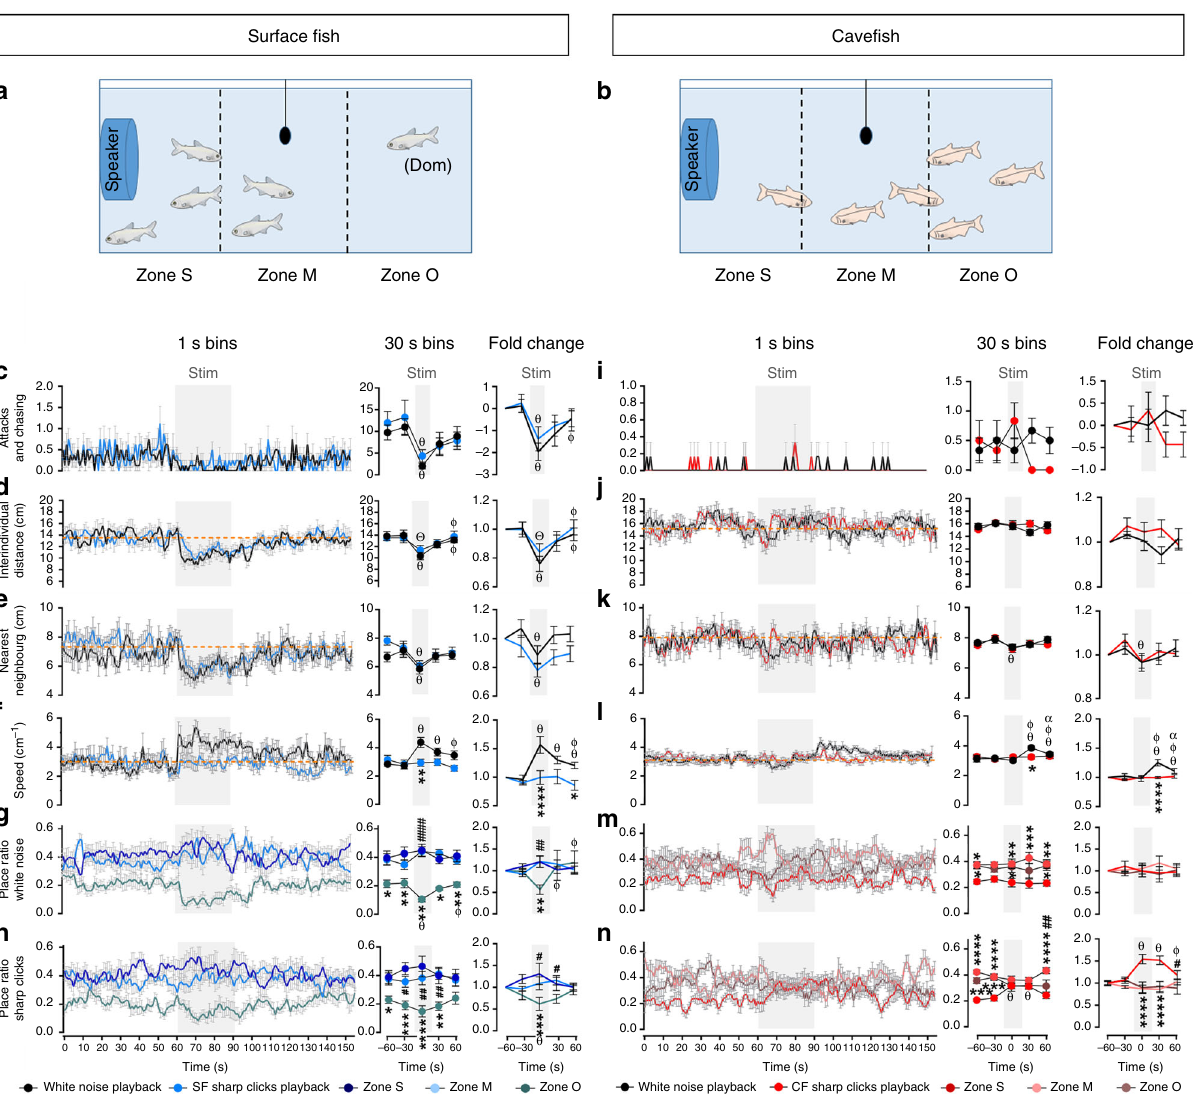
Fig. 5 Effect of Sharp Clicks or white noise play-back on fi sh behavior. Several behavioral parameters were measured before, during and after play-back (grey area, Stim) of Sharp Clicks (colored lines) or white noise (black lines) in surface fi sh (blue graphs, left columns) and cave fi sh (red graphs, right columns). Results are presented at one second bins and 30 s bins, as well as in fold change respective to the “ before sound play-back ” condition. a , b , Schemes of the experimental set-up, with representative distributions of the fi sh in the 3 zones of the tank, respective to the speaker ( fi sh drawings are from authors). dom, dominant SF individual. See also Supplementary Movies 2-4. c , i , Agonistic behavior. Two-way ANOVA-RM, interactions: F (4,56) = 0.42; p = 0.80 ( c ), F (4,40) = 2.18; p = 0.08 ( i ). d , j , and e , k , average inter-individual distance and nearest neighbor distance, respectively. Two-way ANOVA-RM, interactions: F (4,56) = 0.66; p = 0.62 ( d ), F (4,40) = 2.66; p = 0.05 ( j ), F (4,56) = 1.36; p = 0.26 ( e ), F (4,40) = 0.52; p = 0.72 ( k ). f , l swimming speed. Two-way ANOVA-RM, interactions: F (4,56) = 6.004; p = 0.0004 ( f ), F (4,40) = 11.3; p < 0.0001 ( l ). g , m , and h , n , place preference index in the 3 zones of the aquarium (S, M, O, see color code) during white noise or Sharp Clicks play-back, respectively. Two-way ANOVA-RM, interactions: F (8,84) = 3.9; p = 0 . 0006 ( g ), F (8,84) = 2.08; p = 0 . 047 ( h ), F (8,60) = 0.73; p = 0.66 ( m ), F (8,60) = 5.06; p < 0 . 0001 ( n ); Bonferroni posthocs : p -values < 0.05 – 0.0001 between time points are indicated as compared to baseline before stimulation ( θ ), to the stimulation period ( Φ ), to 30 s post stimulation ( α ), and Θ indicates trends as compared to before stimulation ( p ≤ 0.08); p -values < 0.05 – 0.0001 at time points between white noise versus sharp clicks playbacks (*), from zone S (*) and from zone O (#). Stim, play-back stimulation; zone S, M, O, close to speaker, median zone, opposed to the speaker, respectively. Data are means or fold changes ± SEM. See also Supplementary Data 3 for exhaustive statistics. Source data are provided as a Source Data fi